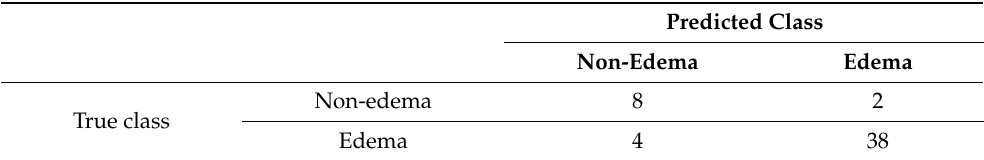
Table 4. Confusion matrix for the best predictive